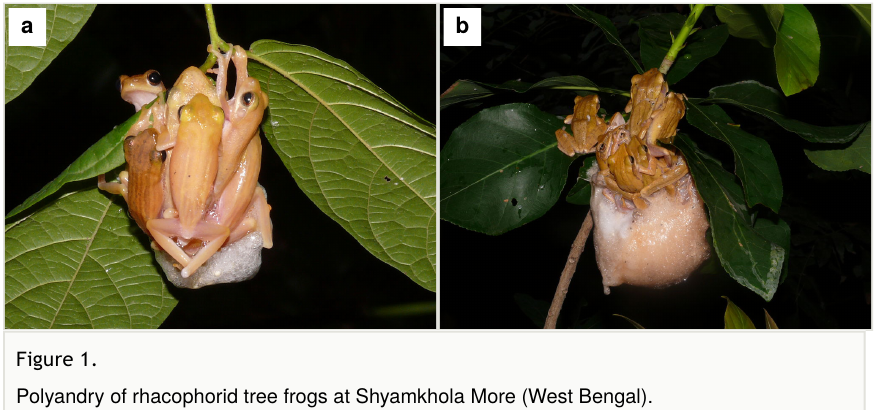
Figure 1. Polyandry of rhacophorid tree frogs at Shyamkhola More (West Bengal). a : Amplexus of fi ve males and one female of Chiromantis simus (Annandale). b : Amplexus of seven males and one female of Polypedates leucomystax (Gravenhorst).